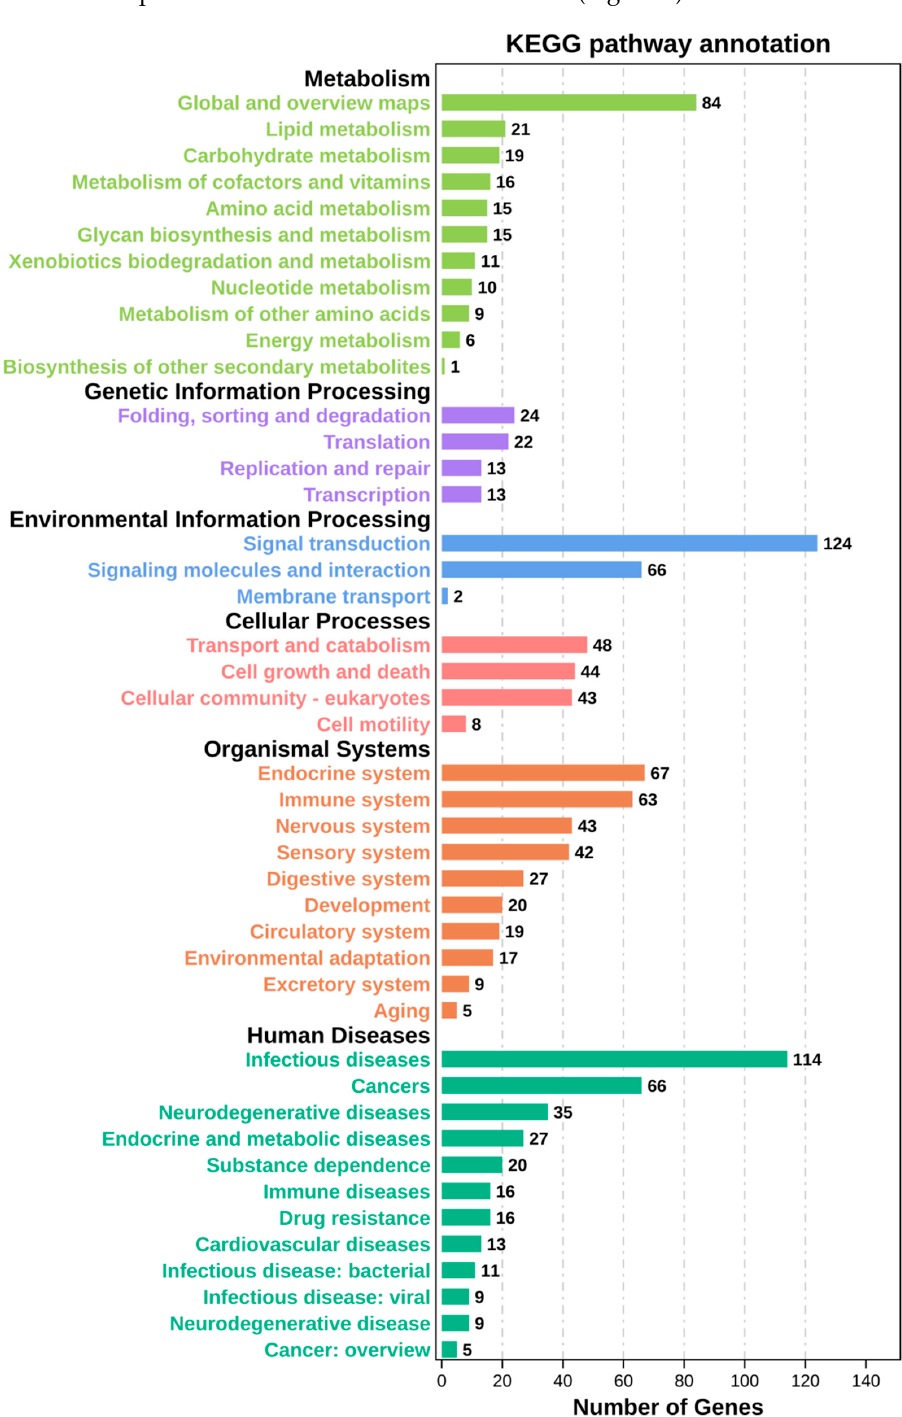
Figure 6. KEGG analysis of trend 11. Bar chart of enrichment of genes in KEGG pathways. The ordinate shows the pathway names in different colors, and the abscissa shows the number of genes in corresponding pathways.